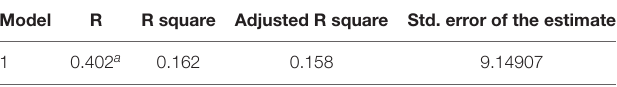
TABLE 6 | Regression model output.